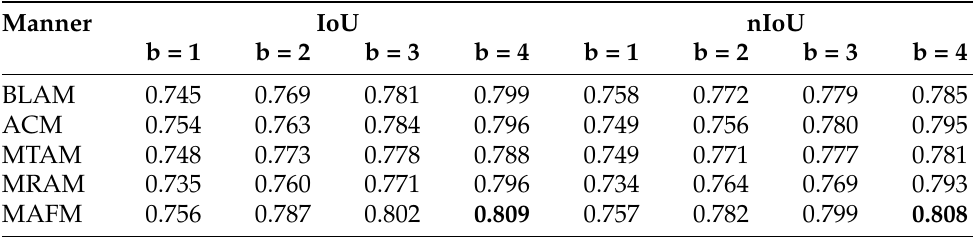
Table 5. Performance comparison of different fusion modules on the SIRST dataset.